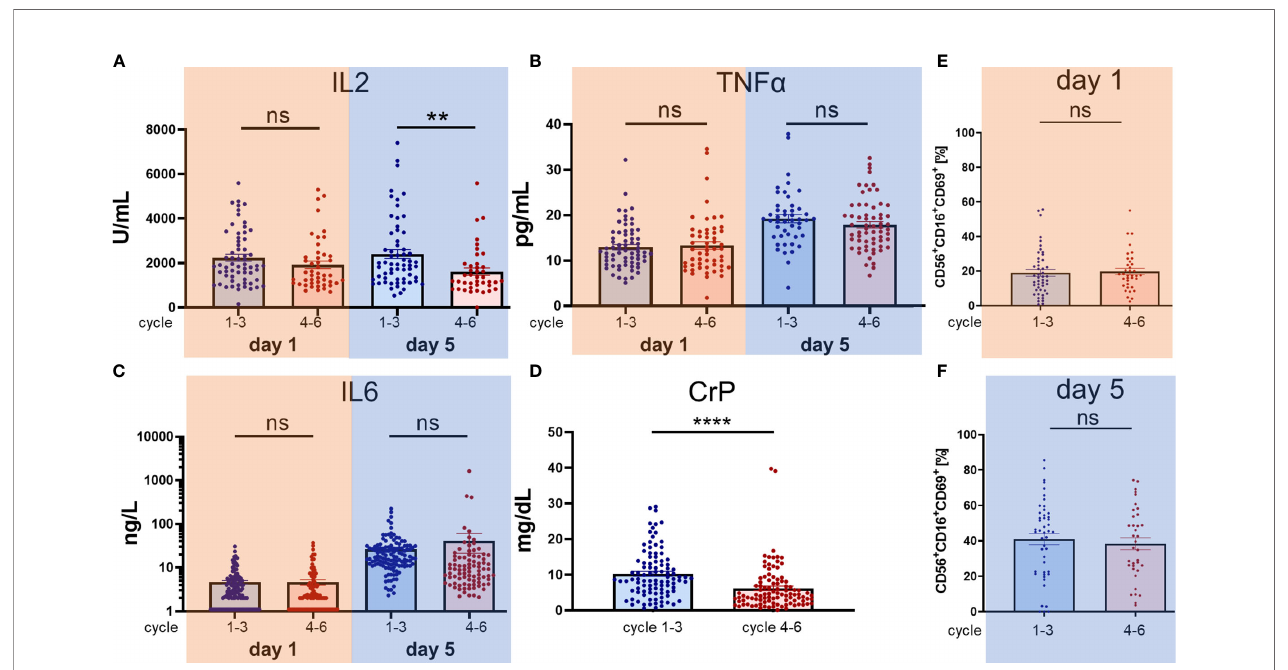
FIGURE 3 | Comparison of cytokine secretion and activation of NK cells during cycles 1 – 3 without IL2 administration and cycles 4 – 6 with low dose subcutaneous IL2 administration. In contrast to cycles 1 – 3 starting as early as 60 days post haploidentical HSCT, in cycles 4 – 6 at days 6, 8, and 10 subcutaneous IL2 is administered at 1E06 IU/m 2 /day. Consequently, we performed a systematic analysis and comparison of cytokine secretion and the activation of NK cells between the cycles 1 – 3 versus the cycles 4 – 6. We compared the levels of the proin fl ammatory cytokines (A) IL2, (B) TNF a , (C) IL6 and (D) CrP in serum of patients or lithium heparin plasma and the percentage increase in number of activated NK cells (E, F) . Every single dot represents an independent single value per cycle and patient used from cycles 1 – 6 (A – D) but as indicated in (E) cycles 1 – 3 and (F) cycles 4 – 6. For the comparison of (A) IL2 day 1 n cycles 1 – 3 = 62/n cycles 4 – 6 = 46, day 5 n cycles 1 – 3 = 62/n cycles 4 – 6 = 41, (B) TNF a day 1 n cycles 1 – 3 = 67/n cycles 4 – 6 = 55, day 5 n cycles 1 – 3 = 63/n cycles 4 – 6 = 47, (C) IL6 day 1 n cycles 1 – 3 = 129/n cycles 4 – 6 = 97, day 5 n cycles 1 – 3 = 125/n cycles 4 – 6 = 86 was available in pair values and for (D) CrP n = 99 single values were used. NK cell immunophenotype was assessed by fl ow cytometry and was de fi ned as the CD56 + CD16 + and CD3 − subset of lymphoid cells. The early activation marker CD69 was used to distinguish resting (CD69 − ) from activated (CD69 + ) NK cells, day 1 and 5 n cylces 1 – 3 = 47, n cylces 4 – 6 = 36, day 1 p = 0.78, day 5 p = 0.58. Statistical analysis was done by two-tailed unpaired t-test. P-values below 0.05 were de fi ned signi fi cant. ** = <0.01, **** = <0.0001. ns, not signi fi